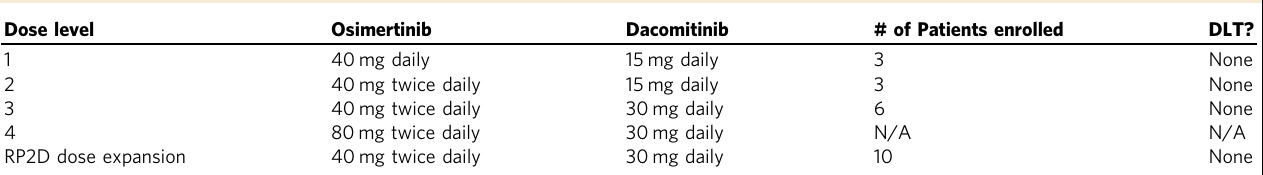
Table 1 Dose levels in the dose-escalation study.